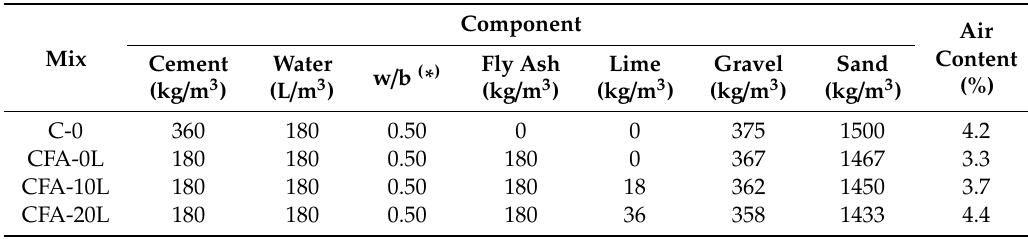
Table 1. Mixture proportions of concretes and air content of fresh concrete.